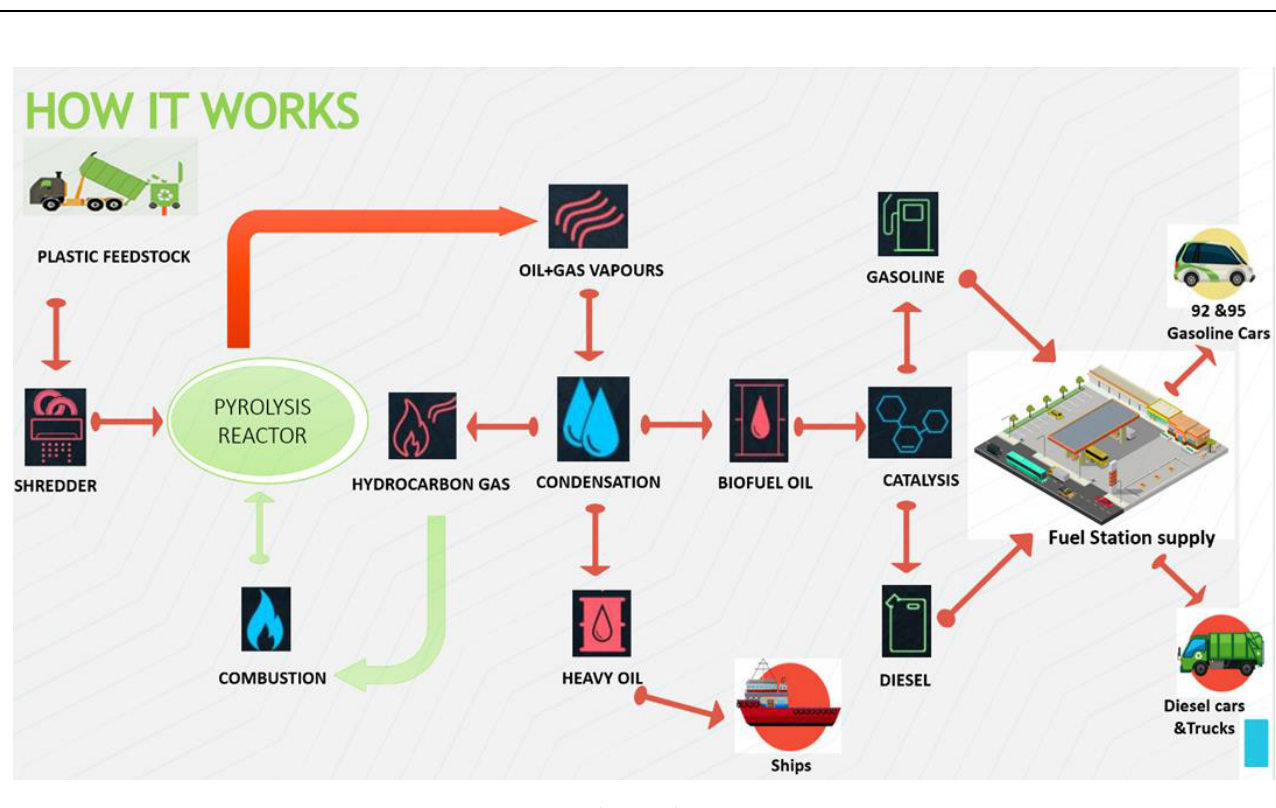
Figure 2. The pyrolysis process.